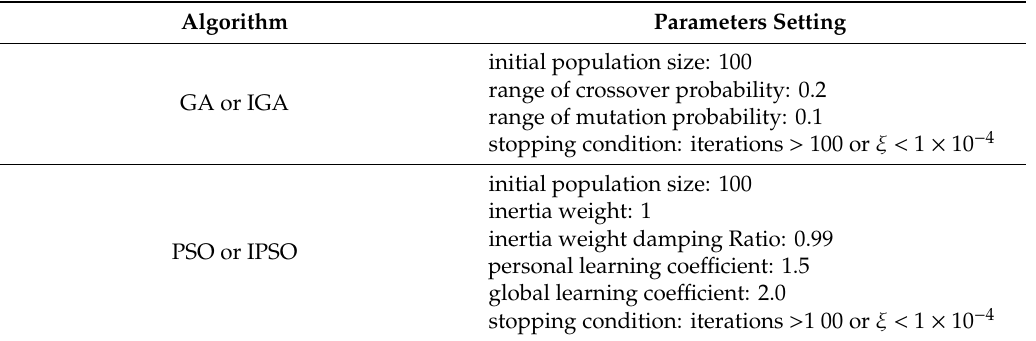
Table 2. Parameters of optimization